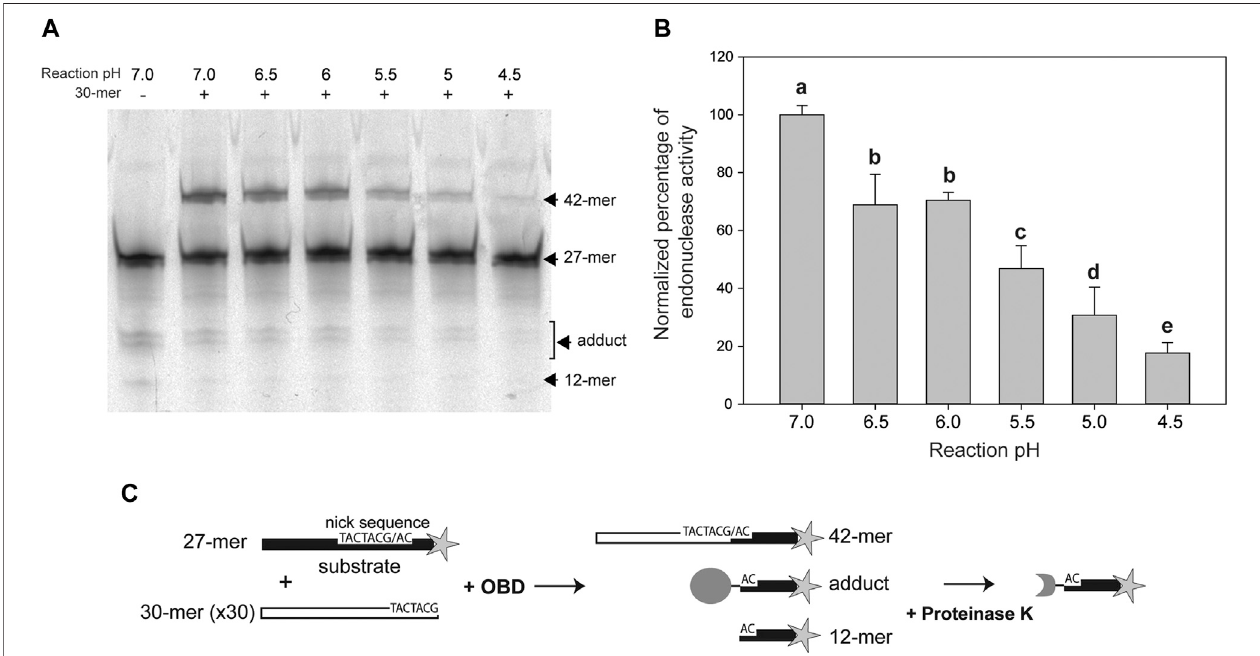
FIGURE 2 | Endonuclease activity of OBD at different pHs. (A) Reaction product pattern generated by the nicking and strand-transfer activities of OBD on ssDNA oligos at the indicated reaction pHs. The 27-mer oligo substrate (500 nM), labeled at its 3 ′ -end with the fl uorescent dye Cy5 (indicated by a star in panel (C) ), and a 30- fold molar excess of the unlabeled 30-mer oligo were incubated with the protein (10 nM) at 25 ° C for 2 min. The resultant fl uorescent oligos were analyzed by electrophoresis in 20% PAA-urea gels, and visualized with the aid of a FLA 3000 (FUJIFILM) imaging system. A representative gel from one of four independent experiments isdisplayed. The bands corresponding tothe 12-mer DNA generated by cleavage ofthe 27-mer substrate and to the 42-mer DNA strand-transfer product are indicated. The covalent adduct is represented by a set of 2 – 3 bands that arise from partial digestion of OBD with proteinase K. (B) Vertical bar graph showing the percentage of reaction products rendered by OBD at the indicated pHs. The sum of all reaction products was considered for catalytic activity quanti fi cation. The percentageofactivityobtainedatpH7.0wasusedasareferencefornormalization.Verticalbarsrepresenttheaveragevalueoffourindependentexperiments.Errorbars represent standard deviations. Average values with different lowercase letters were signi fi cantly ( p < 0.05) different. (C) Schematic description of the different reaction